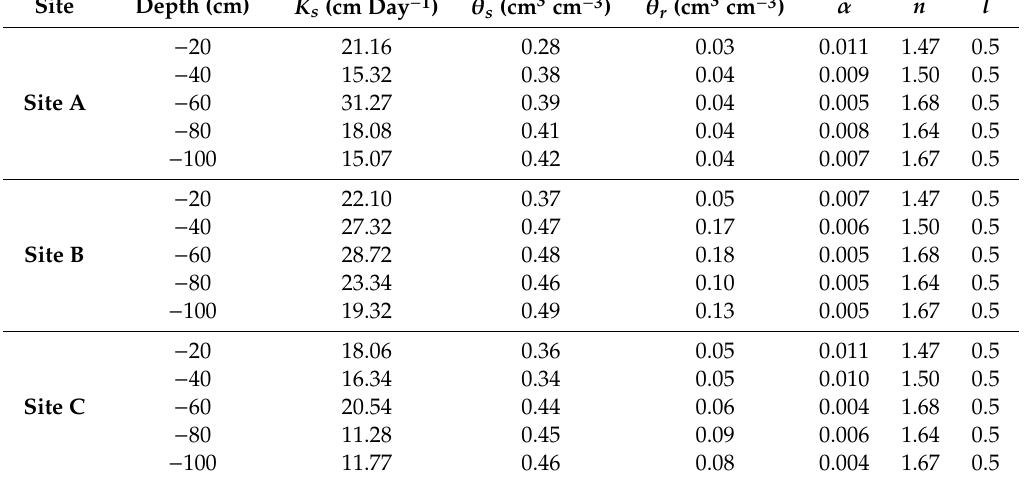
Table 3. Soil hydraulic parameters of simulating region in di ff erent soil depths. Saturated hydraulic conductivity ( K s ) and saturated water content ( θ s ) were measured in the field, while α , n and θ r were predicted through a neural network. In the table, θ r represents the residual moisture content, while θ s the saturated moisture content, α the empirical parameter, n the porous medium parameter, K s the saturated hydraulic conductivity, l the pore correlation parameter.